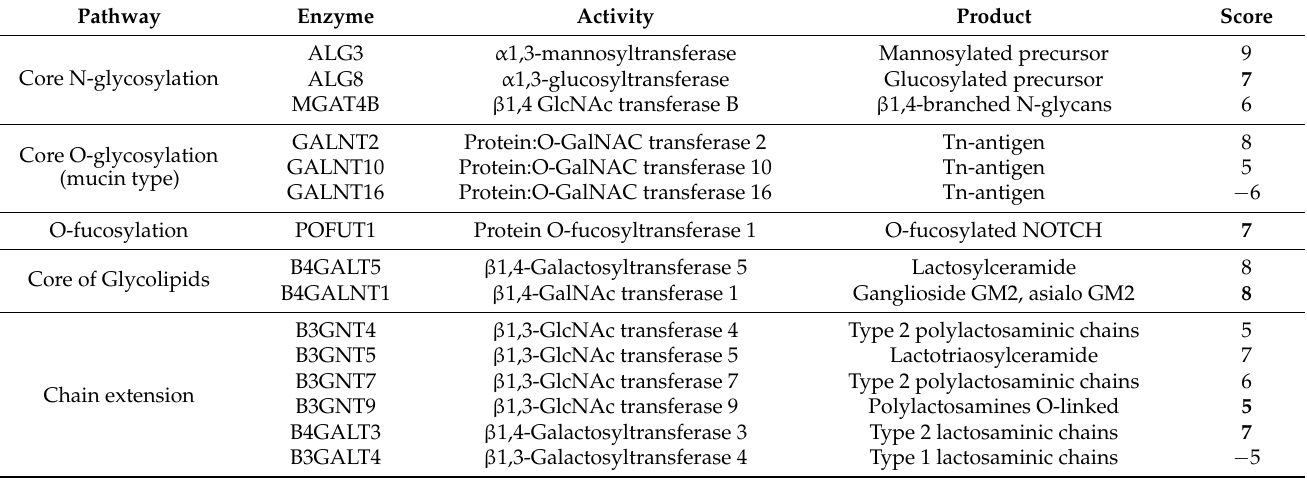
Table 2. Glycosyltransferases show an association with prognosis in a large number of